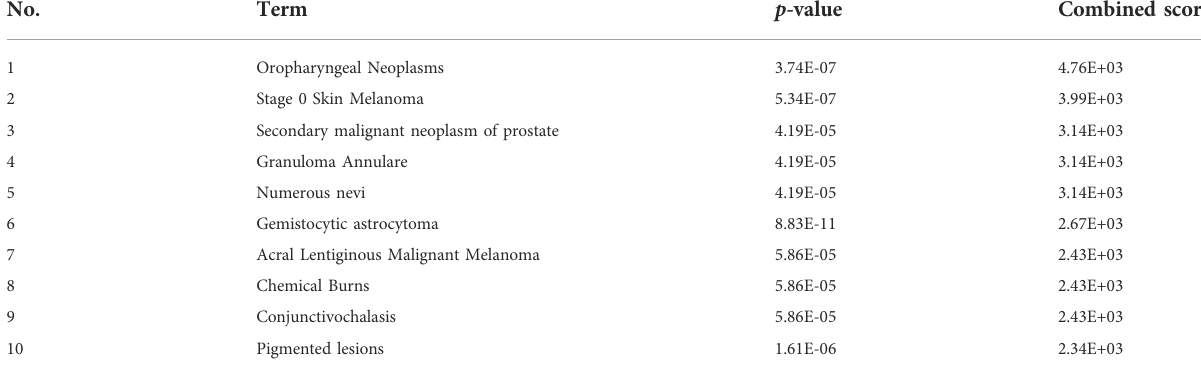
TABLE 3 The top 10 gene-disease enrichment term based on the combined